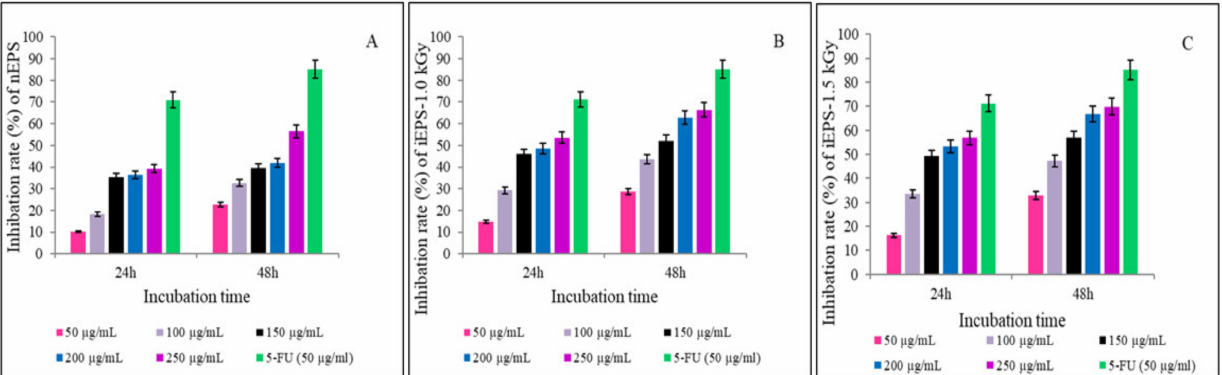
Figure 8. Antitumor effects of ( A ) purified nEPS, ( B ) iEPS–1.0 kGy, and ( C ) iEPS–1.5 kGy on HT 29 cancer cell line. 5-FU was used as positive control. All values were expressed as means ± SD of three